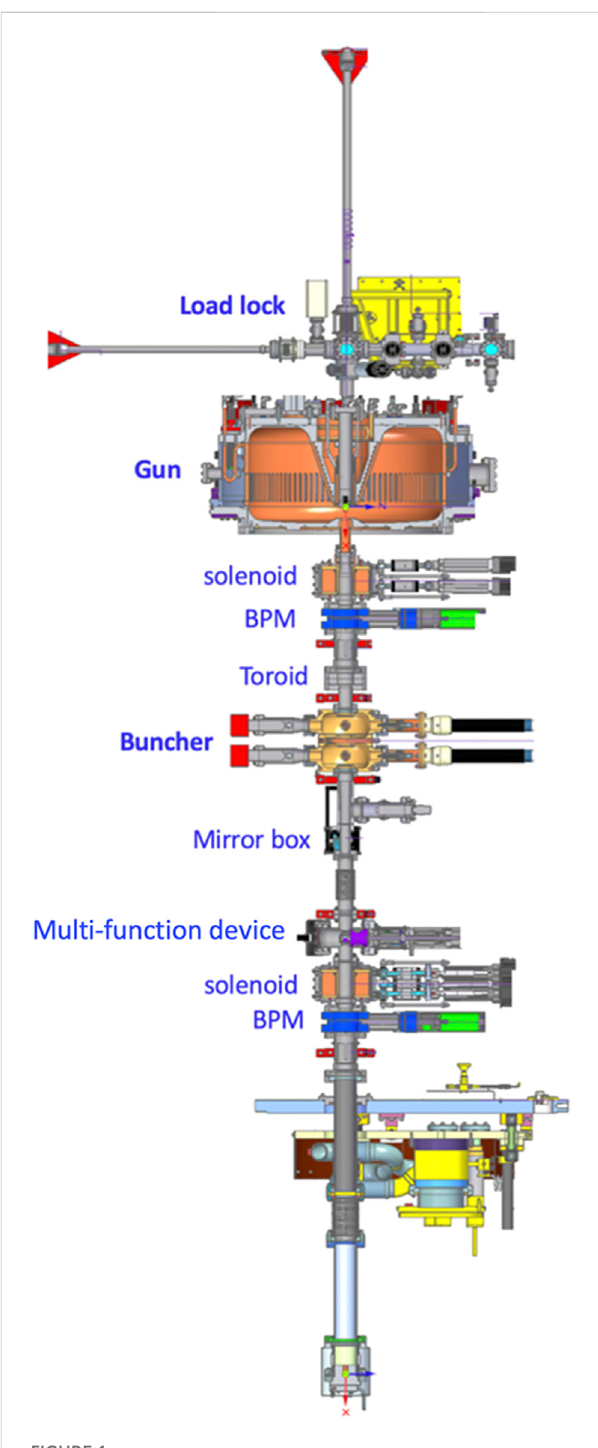
FIGURE 1 Schematic of LCLS-II electron